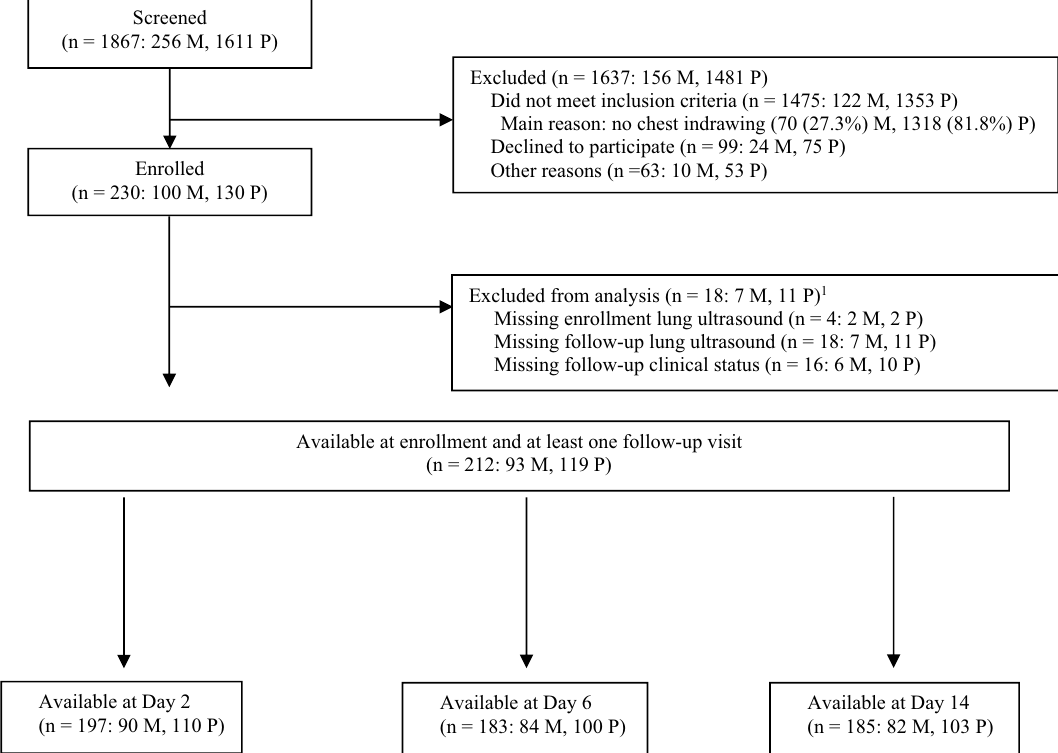
Figure 1. Flow of children with chest-indrawing pneumonia by country: Mozambique (M), Pakistan (P). 1 Reasons for exclusion from analysis are not mutually